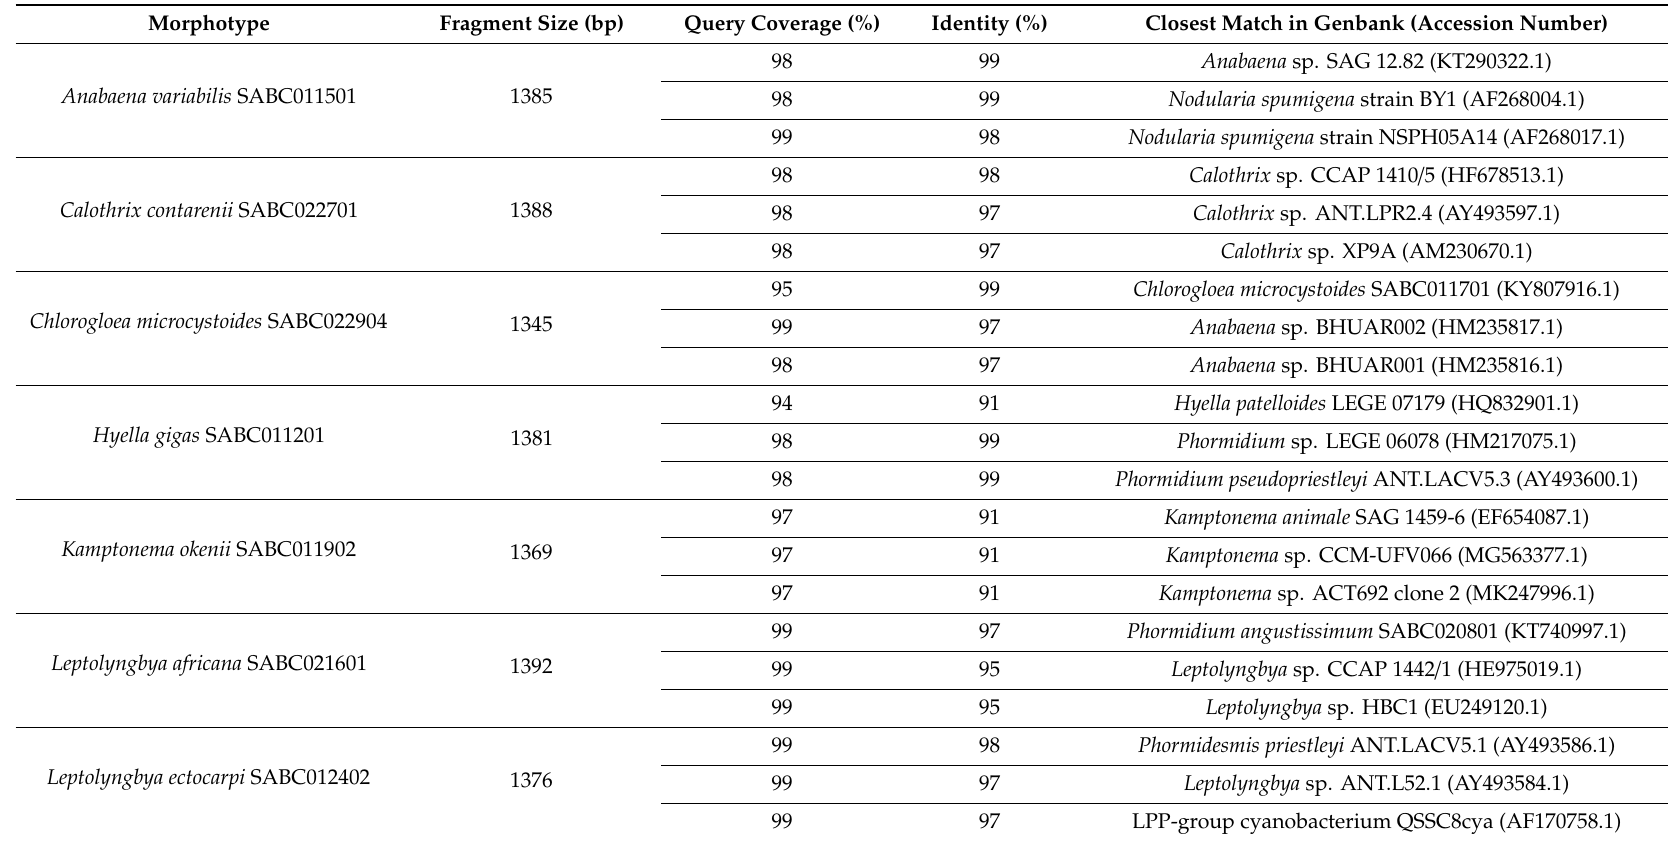
Table 4. 16S rRNA gene sequences of marine cyanobacteria studied and their closest match in